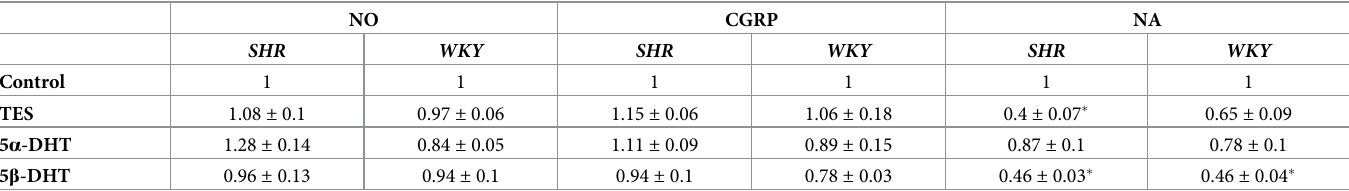
Table 1. Effect of 10 nM testosterone (TES), 5 α -dihydrotestosterone (5 α -DHT) and 5 β -dihydrotestosterone (5 β -DHT) on the basal release of NO, CGRP and NA in the mesenteric artery of spontaneously hypertensive (SHR) and normotensive (WKY)